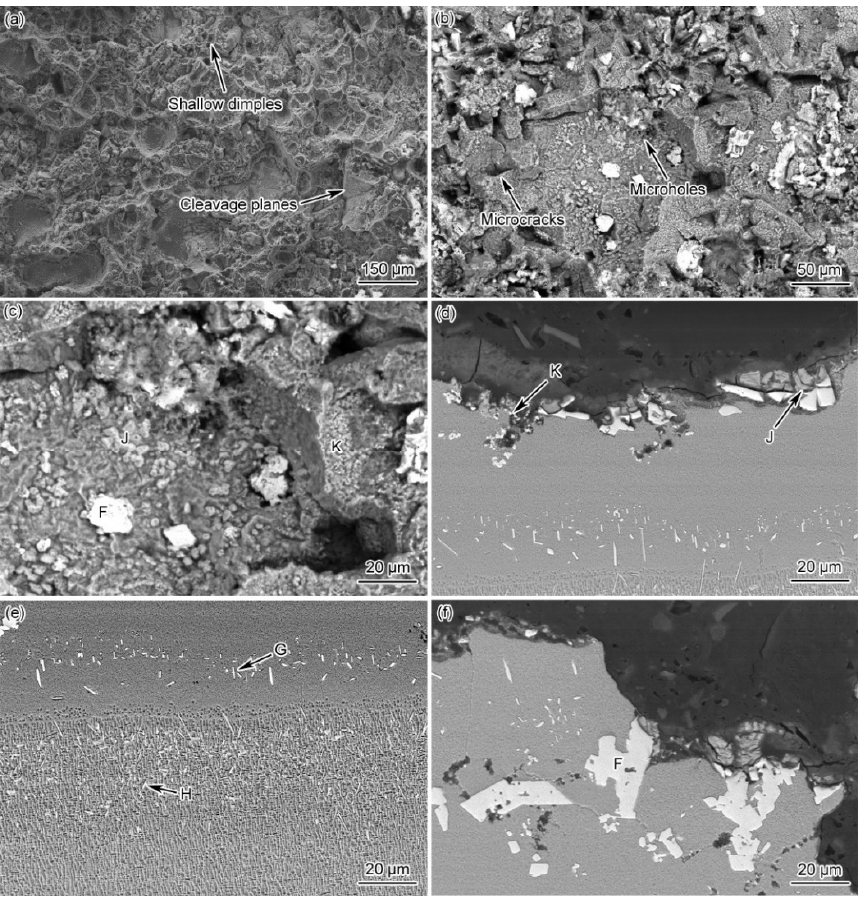
Figure 13. The morphologies of the fractured surface and longitudinal section of the PBHT-processed joints (F, G, J, K represent Area-F-G-J, and -K, respectively): ( a – c ) fracture morphology and ( d – f ) longitudinal section morphologies.